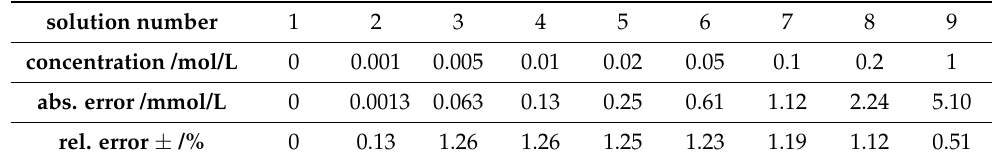
Table 1. Different concentration levels of cerium nitrate for the sweep